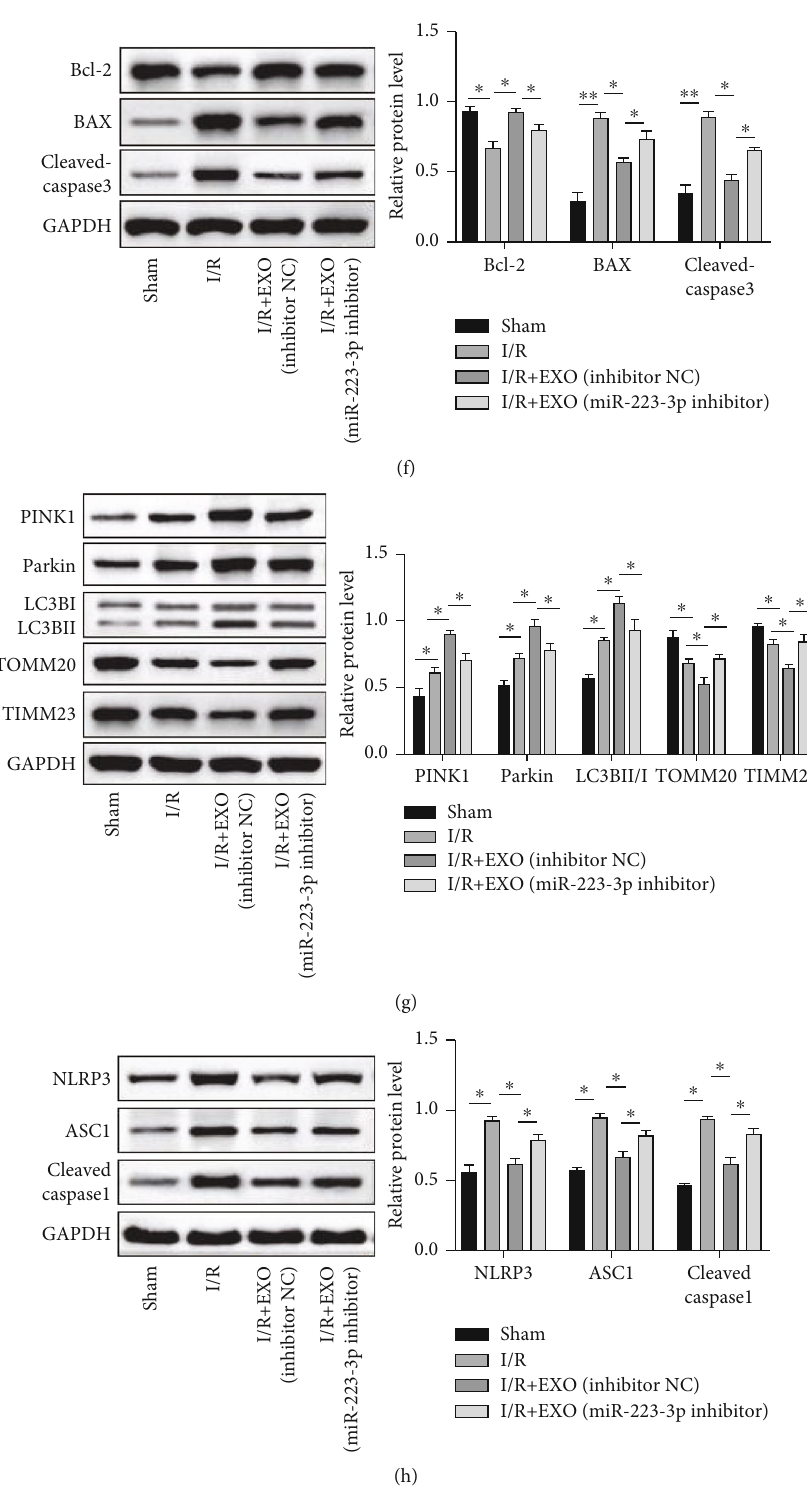
Figure 4: Exosome-delivered miR-223-3p mediated the protective e ff ect of exosome in RIRI. Mice were treated with miR-233-3p-depleted EVs and then subjected to I/R injury. (a) The expression of miR-223-3p was determined using qPCR. (b) Histological injury was evaluated based on H&E staining. (c and d) The blood urea nitrogen (BUN) and serum creatinine (sCr) contents were detected using the speci fi c kits. (e) Tissue apoptosis was detected using the TUNEL assay kit. (f) The protein levels of BAX, cleaved caspase-3, and Bcl-2 were con fi rmed using the western blot analysis. (g) Expressions of the mitophagy markers were detected using the western blot analysis. (h) The expressions of NLRP3, ASC1, and cleaved caspase 1 were evaluated using the western blot analysis. n = 6 . ∗ P < 0 : 05 ; ∗∗ P < 0 : 01 ; ∗∗∗ P < 0 : 001